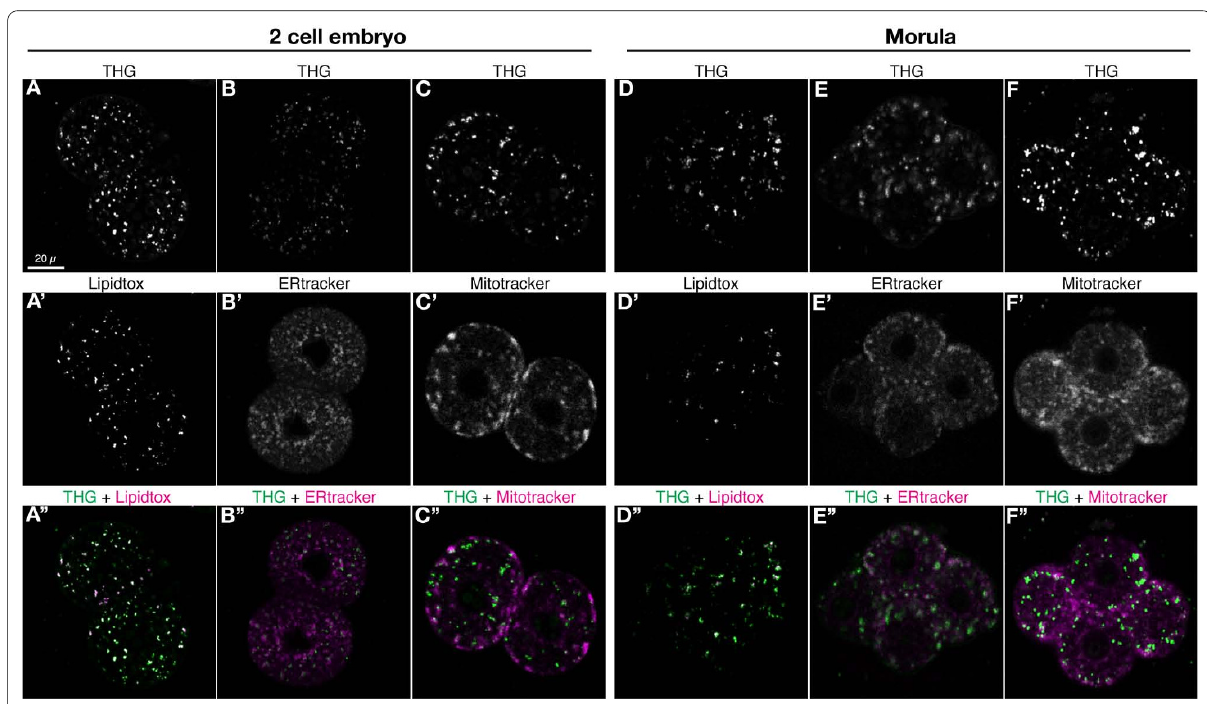
Figure 2 Colocalization of THG signal with lipid droplets . (A - A'' and D - D'') Representative 2-cell and morula stage embryos stained with the LD dye LipidTox, showing good colocalization of THG signal with LD. (B - B', C - C', E - E', F - F') 2-cell and morula stage embryos stained with ER and mi- tochondrial dyes, showing poor colocalization of THG signal with these organelles. The scale bar in (A) = 20 μm and applies to all